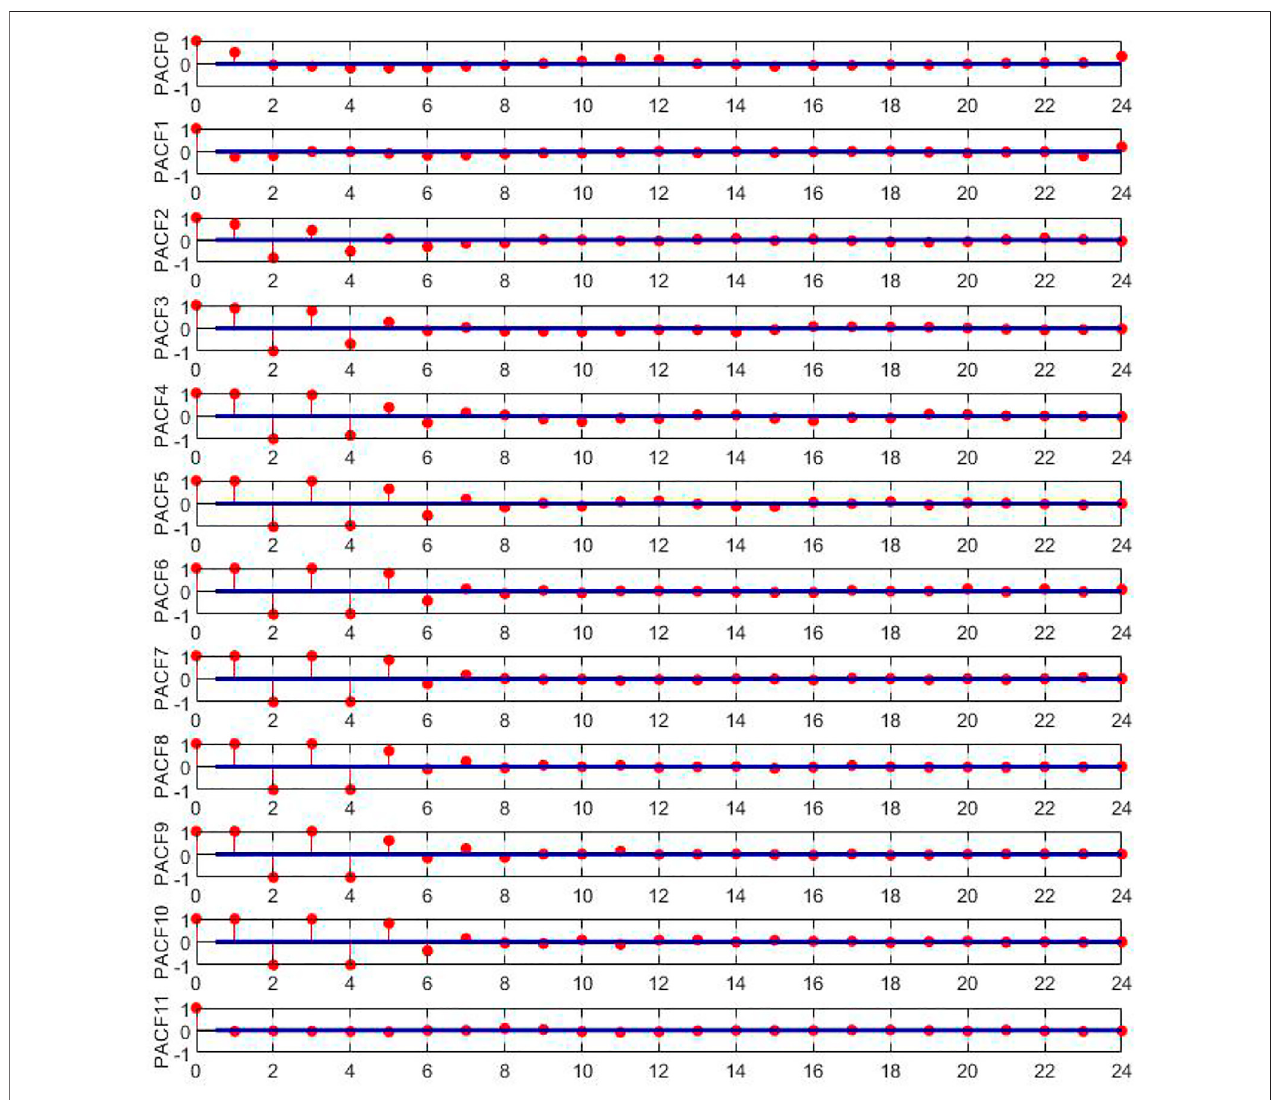
FIGURE 3 | PACF values of each series for the Xinfengjiang Reservoir.